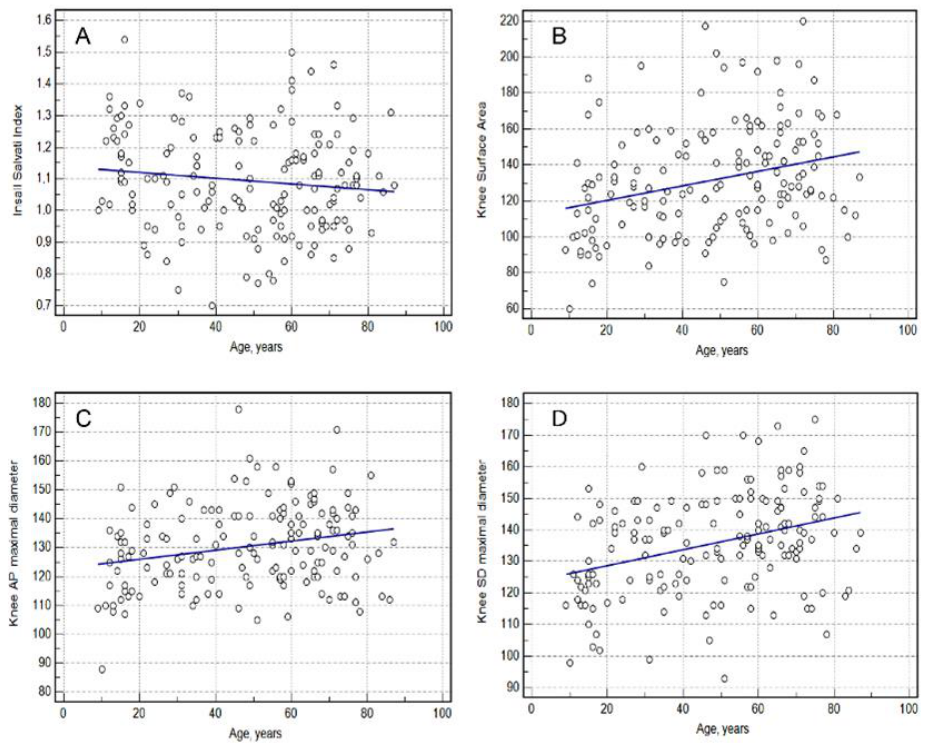
Figure 2. Relationship between knee measurement and age. ( A )—Insall Salvati index; ( B )—Knee Surface Area; ( C )—Knee AP (anterior-posterior) Maximal Diameter, ( D )—Knee SD (sinistro-dexter) Maximal